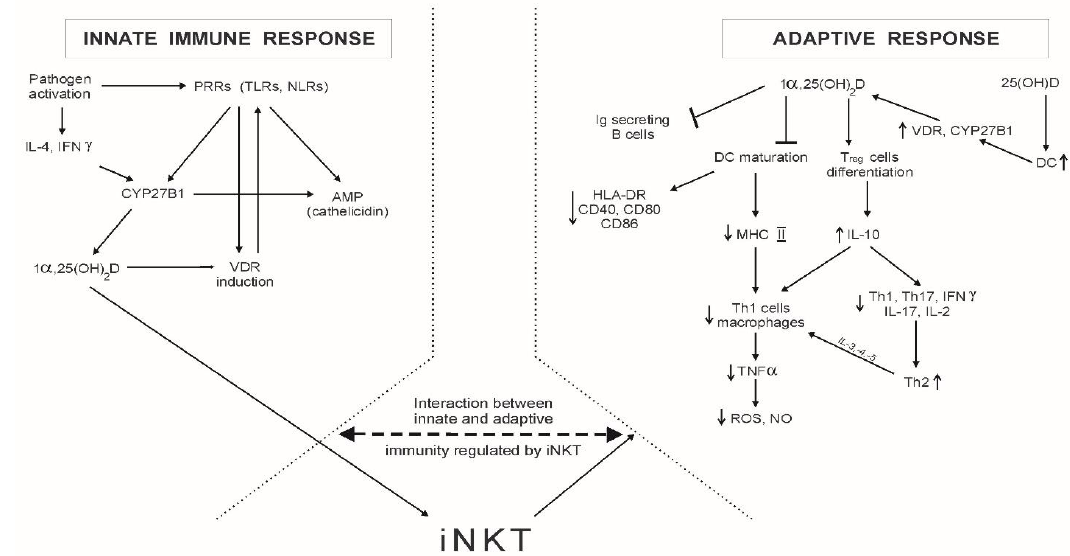
Figure 2. The role of vitamin D in the immune response. Abbreviations: PRRs (pathogen recognition receptors); TLRs (Toll-like receptors); NLRs (nucleotide-binding oligomerization domain (NOD)-like receptors); IL (interleukin); IFNγ (interferon γ); CYP27B1 (cytochrome P450-associated 25(OH)D(3)-1 α -hydroxylase); AMP (antimicrobial peptides); VDR (vitamin D receptor); iNKT (invariant NK T cells); Ig (immunoglobulin); DC (dendritic cells); Treg cells (regulatory T cells); HLA-DR (human leukocyte antigens); CD (costimulatory molecules); MHC (major histocompatibility complex); Th cells (T- helper cells); IFNγ (interferon γ); ROS (reactive oxygen species); NO (nitric oxide).